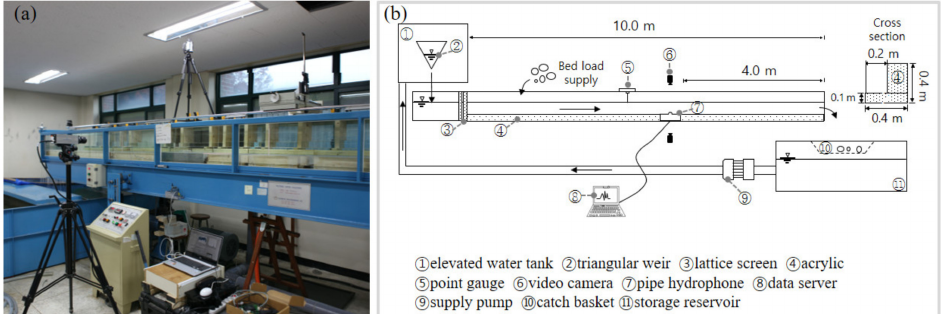
Figure 8. ( a ) Frontal view and ( b ) Schematic of experimental equipment.